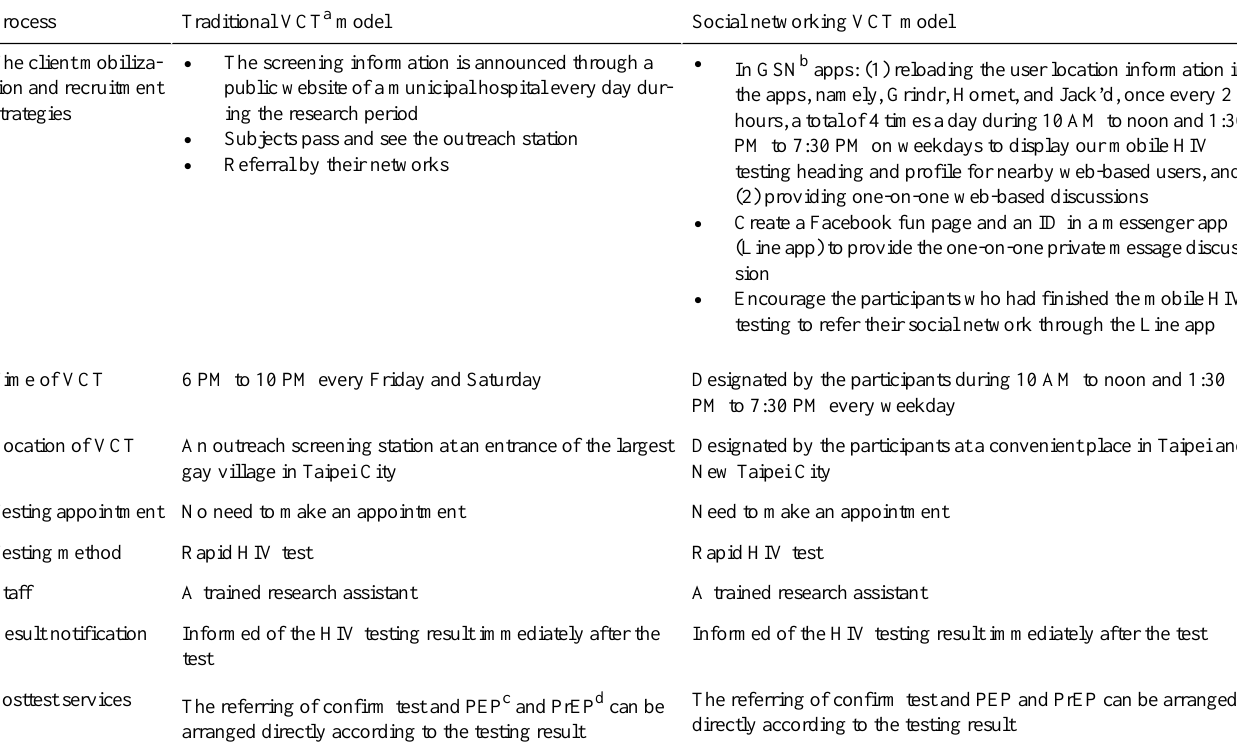
Table 1. The content comparison of the 2 voluntary counseling and testing